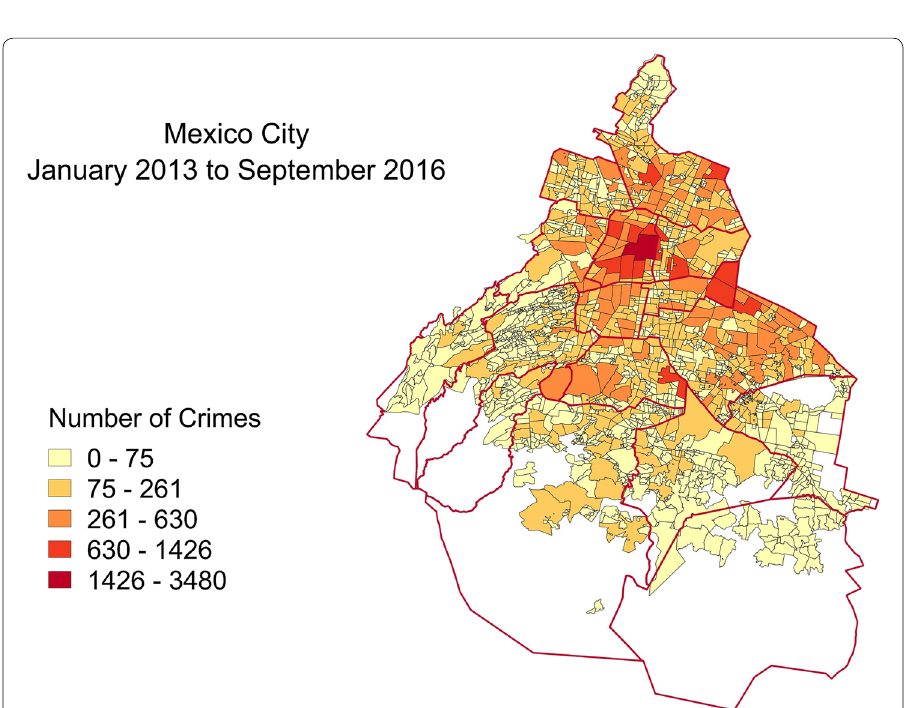
Fig. 2 Number of crimes per segmented neighborhoods in Mexico